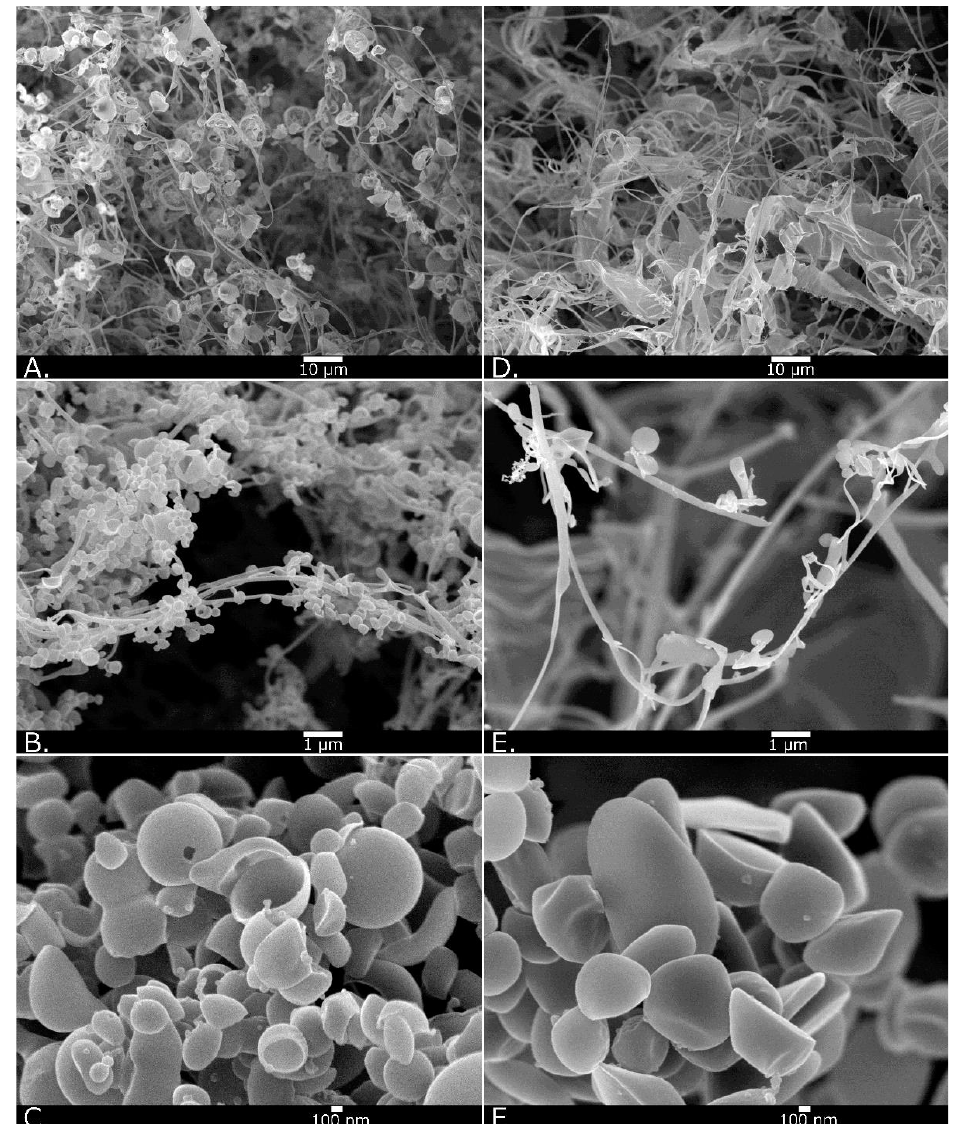
Figure 4. Scanning electron microscopy images of lyophilized material in HSA solution with and without bubbling. Low magnification ( A ; ×1000), high magnification ( B ; ×10,000), and ultra-high magnification ( C ; ×30,000) of bubbled material. Low magnification ( D ; ×1000), high magnification ( E ; ×10,000), and ultra-high magnification ( F ; ×30,000) of material without bubbling. 3.2. NBs Are Regenerated by the Dissolution of Lyophilized Material That Includes HSA Shells The material containing HSA-NBs was redissolved in an equal volume of distilled water before lyophilization. Particle concentrations and distributions before and after lyophilization were back-calculated from measurements obtained via FCM analysis diluted 10-fold (Figure 5A, Table A1). The concentration of HSA-NBs in the solution before vacuum lyophilization was 1.2 × 10 9 /mL. In comparison, the concentration of bubbles in the regenerated NB solution was 7.8 × 10 8 /mL. Following vacuum freeze-drying, 64.5% of the NBs were retained. NBs <200 nm in diameter were preserved at 102.0% (3.0 × 10 8 /mL to 3.1 × 10 8 /mL). NBs 200–500 nm and >200 nm were preserved only 57.3% (7.9 × 10 8 /mL to 4.5 × 10 8 /mL) and 17.7% (1.2 × 10 8 /mL to 2.2 × 10 7 /mL), respectively. Using NTA, the concentration of NBs was found to have been decreased from 13.8 × 10 9 /mL before lyophilization to 4.8 × 10 9 /mL (34.8%) after lyophilization (Figure 5B). The